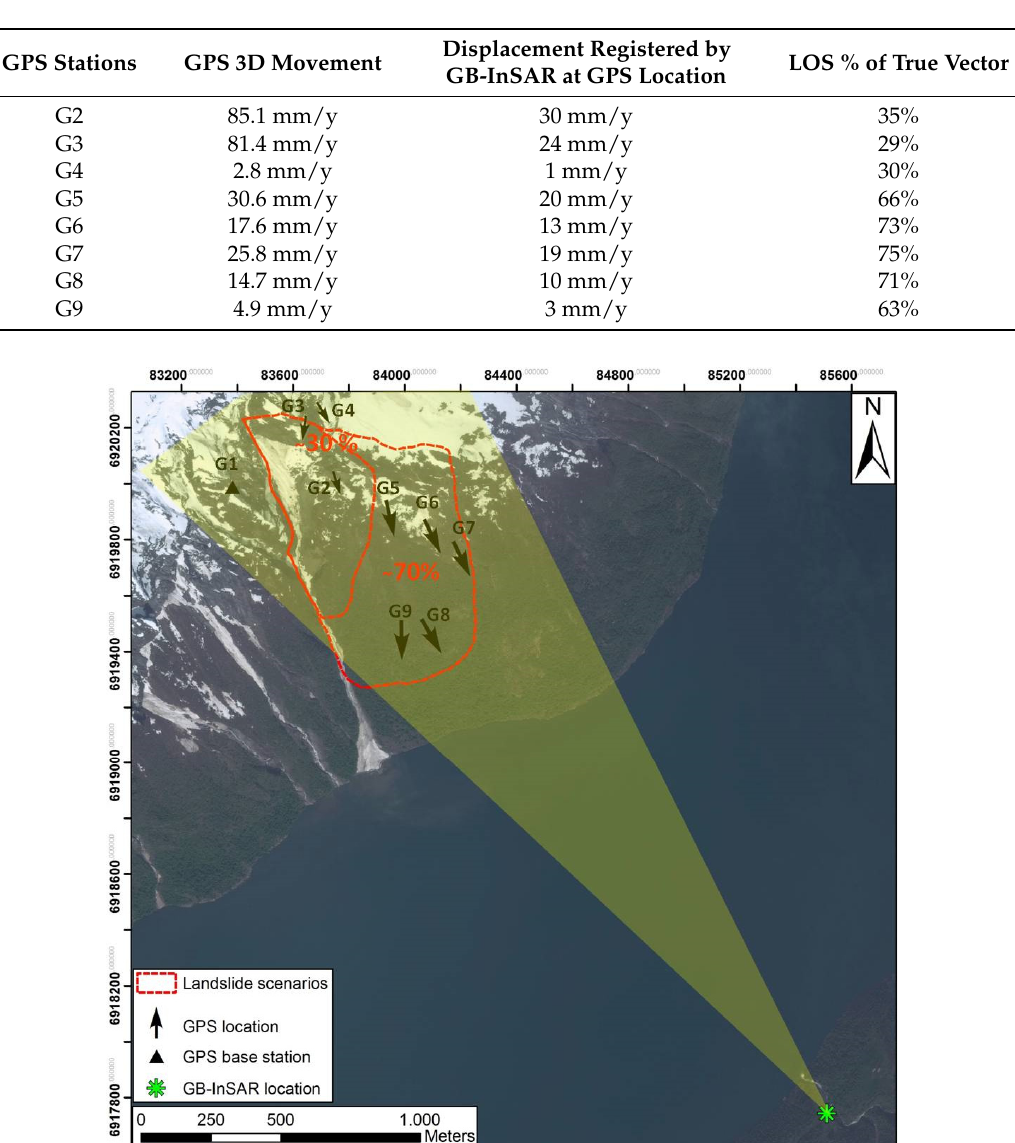
Table 3. Displacement registered by GPSs (from [54]) compared to average displacement registered by GB-InSAR (mm/y) at GPS locations (GPS locations are as shown in Figure 7; G1 represents the base station location).